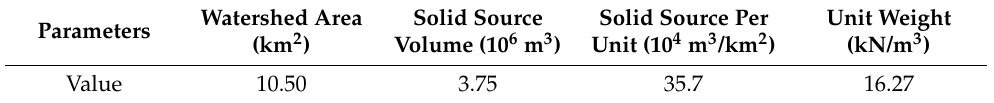
Table 1. Parameters concerning the solid source in the simulation.